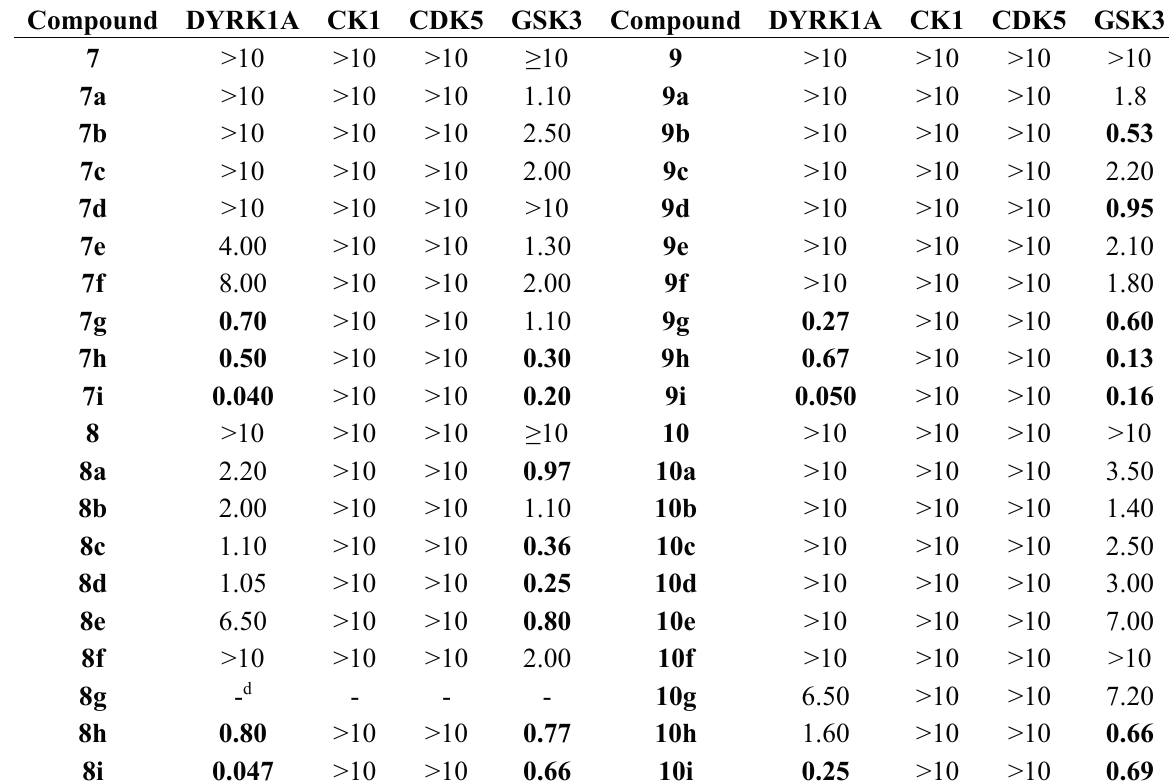
a IC 50 values are reported in μ M. The most significant results are presented in bold; assayed in triplicate. Typically, the standard deviation of single data points was below 10%; c Harmine (IC 50 in μ